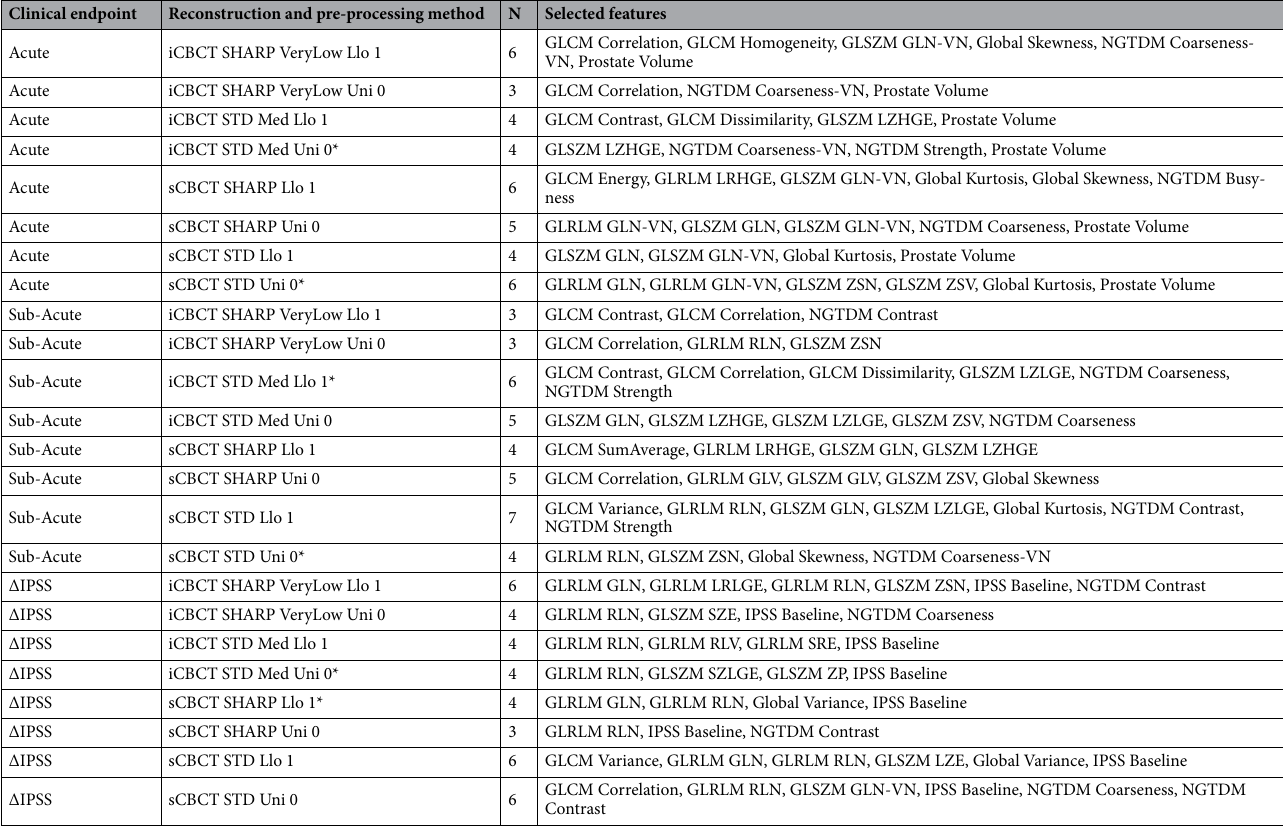
Table 2. Summary of the top DRF found after the feature selection phase organized by clinical endpoint and reconstruction and pre-processing method. Asterisks were placed on the iCBCT and sCBCT reconstruction and pre-processing methods with the best performing AUC in their respective